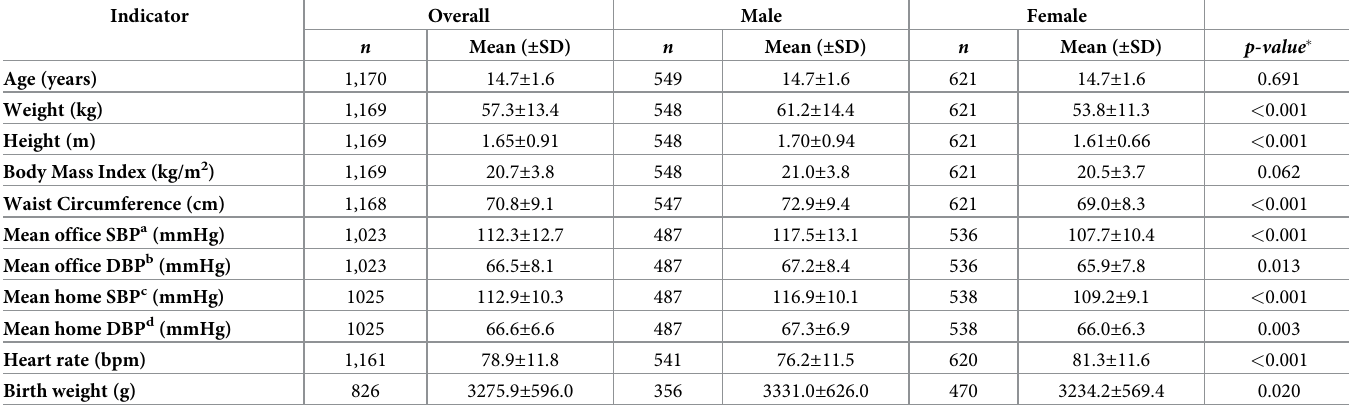
Table 1. Population overall characteristics with sex